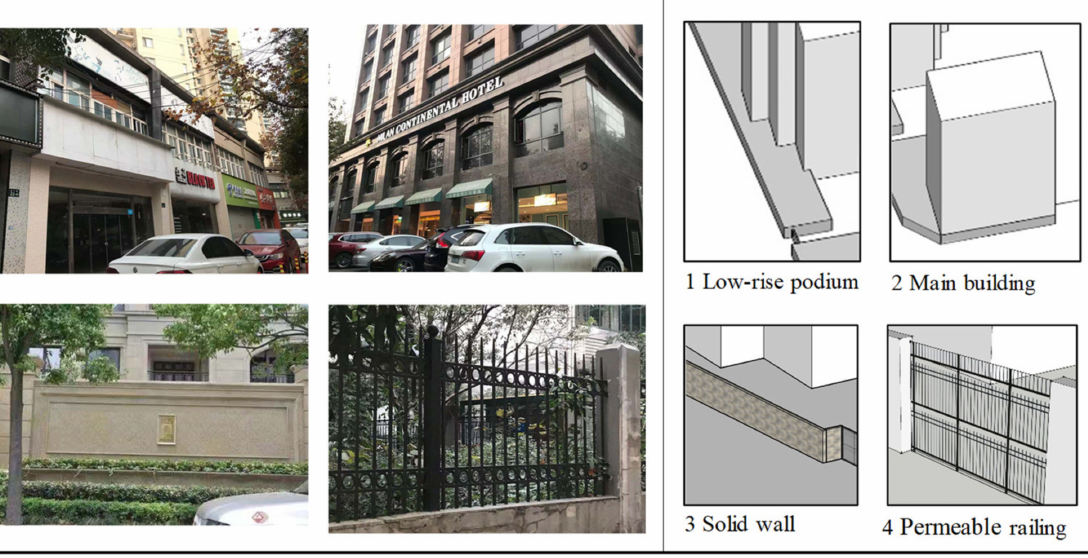
Figure 5. Four typical patterns of enclosed boundaries in residential